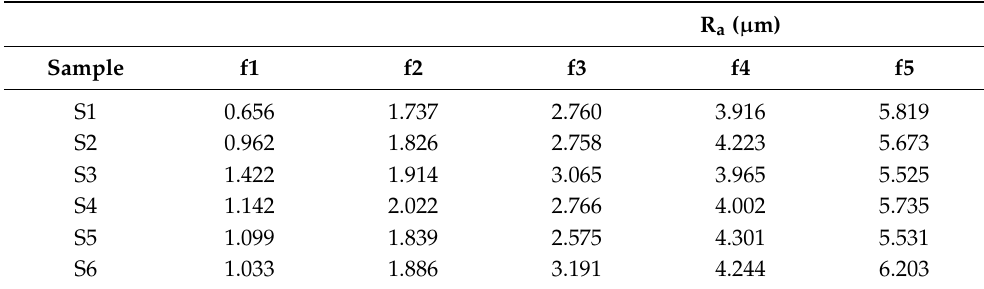
Table 8. Centralization of R a measurements after